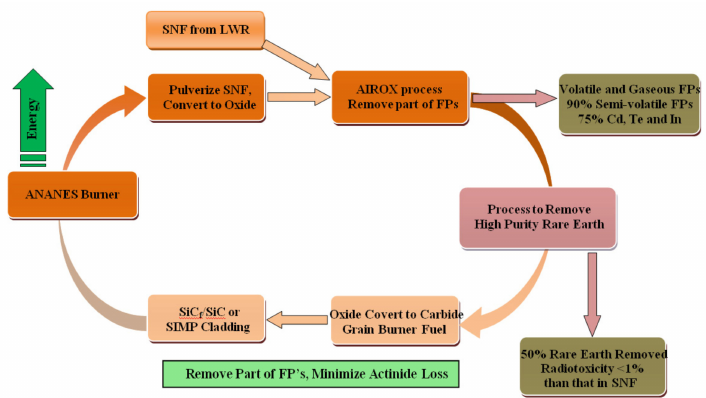
Figure 6. Nuclear fuel recycle system in ADANES. LWR: light water reactor; and HT-dry: high-temperature dry.